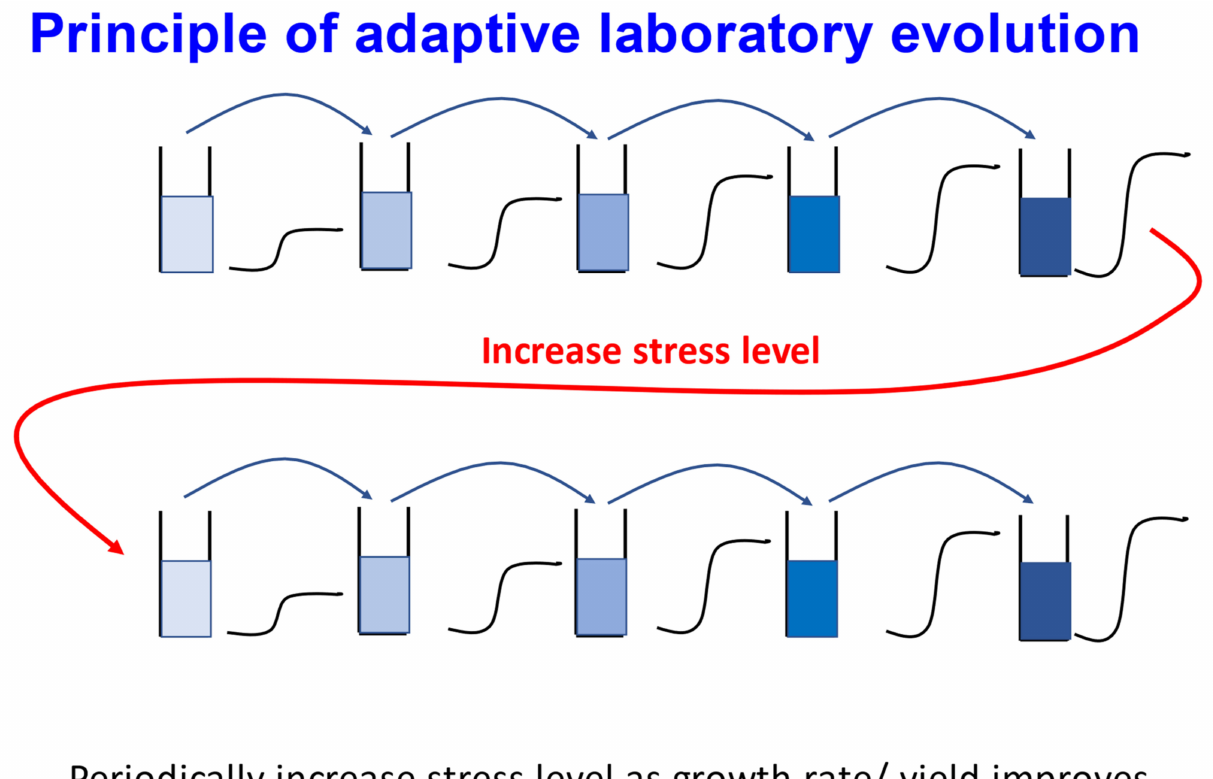
Figure 5. Illustration of the principle of adaptive laboratory evolution (ALE). Cells are exposed to a toxic substance that causes them to grow sub-optimally. Selection leads to strains that can revert to rates and extents of growth shown by the wild type when inoculated into fresh cultures. The stress level is increased and the process continued. Sampling and growth rate measurement can be completely